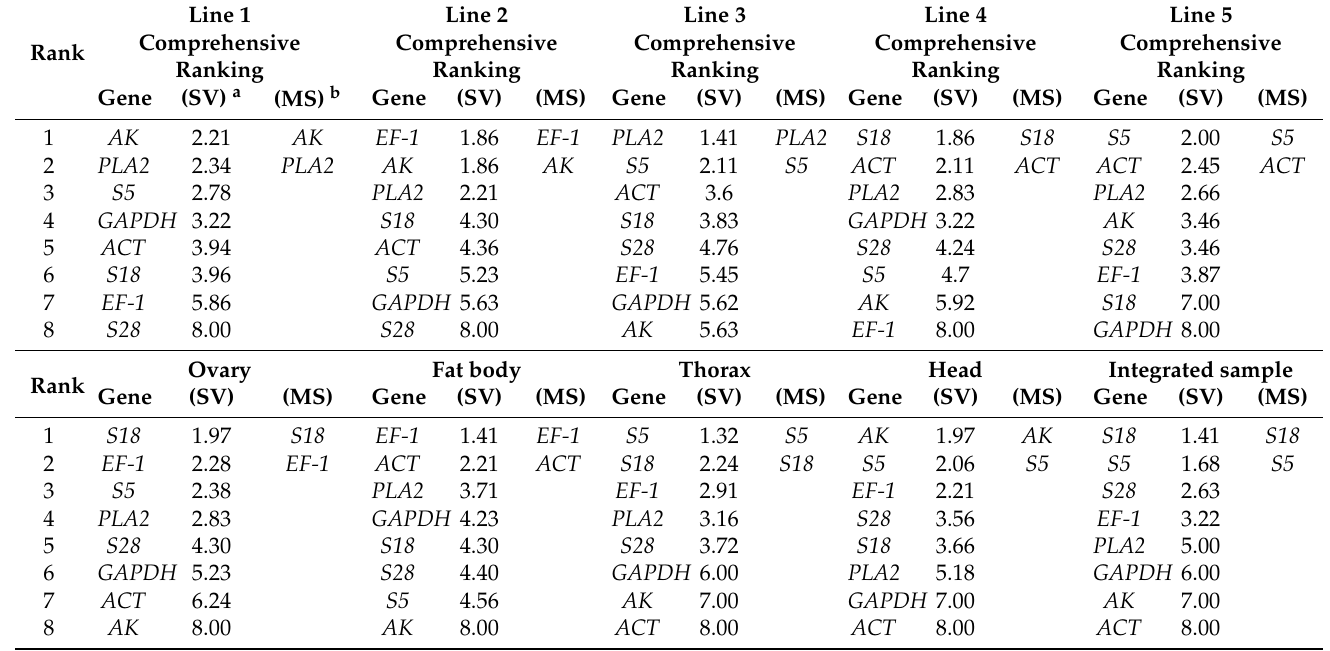
Figure 5. Ranking of eight reference genes by the web-based RefFinder tool. ( A ) Stability ranking of the eight reference genes analyzed by the ∆Ct method presented as the average SD. ( B ) Comprehensive stability ranking of the eight reference genes presented as the geomean of the gene values. Table 4. A comprehensive ranking of the stability values of the eight reference genes. (SV) a indicates the stability value of the genes. (MS) b represents the maximum stability value.